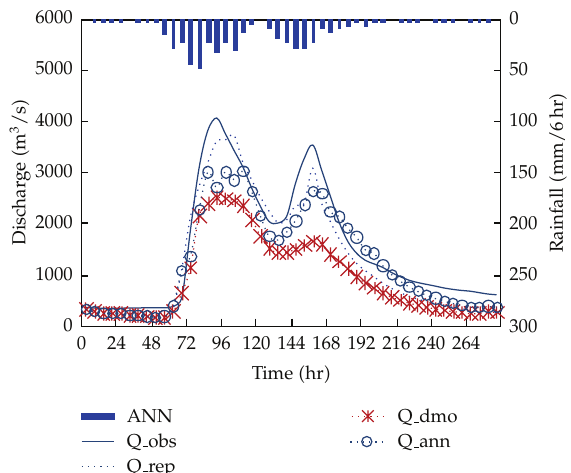
Figure 7: Time series of observed and forecasted hydrographs for the validated flood event on Nov. 1st–7th,